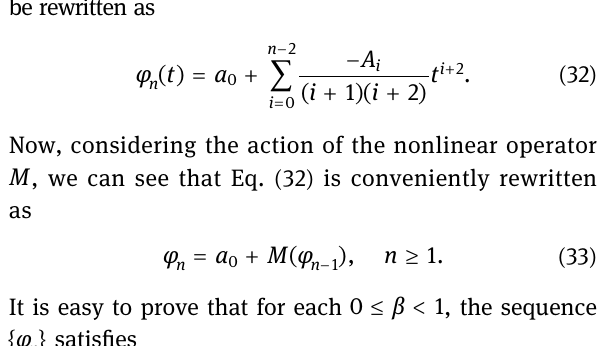
25 ⟨ ⟩ with step - size h 0.25 = ( dots ) . ( c ) Absolute error when we compare k